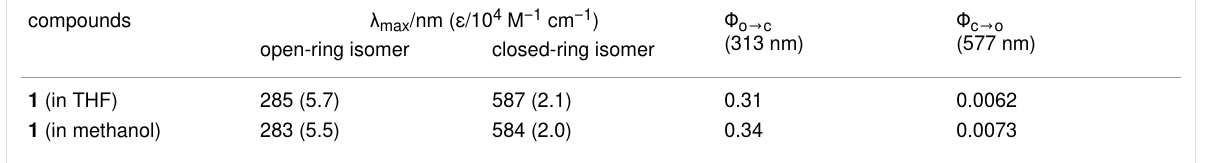
Table 1: Photochromic properties of a diarylethene 1 in methanol and THF. compounds